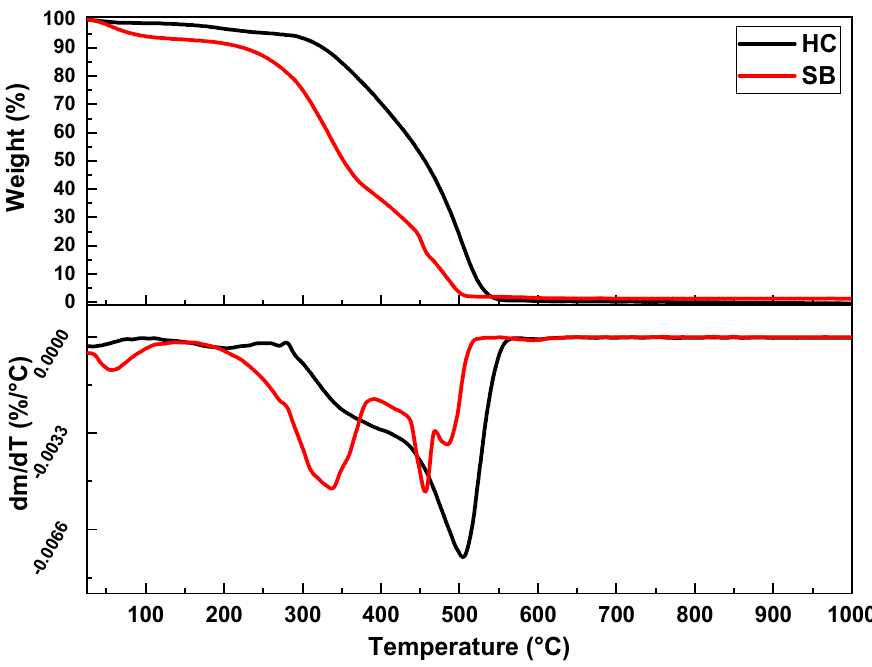
Figure 4. TGA and DTG curves for raw HC (black line) and raw SB (red line). Generally, wood biomass is constituted mainly by hemicellulose, cellulose, lignin and small percentages of other organic and inorganic extractives [41]. Based on the literature study [42,43], softwood is composed of 18–38% cellulose, 15–33% hemicellulose and about 30-60% lignin. The TGA/DTG thermograms (Figure 4) of raw SB and HC present several mass losses. The first mass loss observed for both raw SB and HC is presented from 35–40 ◦ C to 120–140 ◦ C and is attributed to the evaporation of the absorbed water. Thermal treatment applied to obtain the HC particles influenced the mass loss at this stage, which is only 1%, compared to the raw SB, which loses about 7%. TGA analyses (Figure 4) show that the thermal stability of SB is divided into two distinct and complex stages, while in the case of HC, this behaviour appears as a broad and complex degradation mechanism